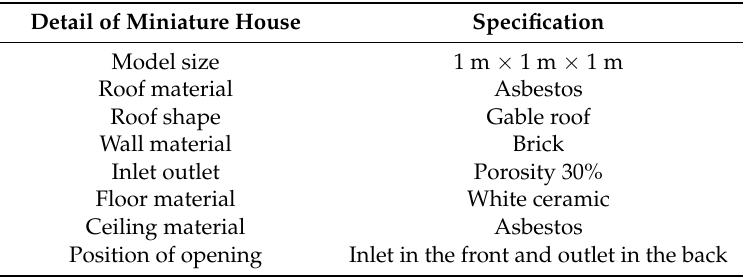
Table 1. Detail of miniature house.